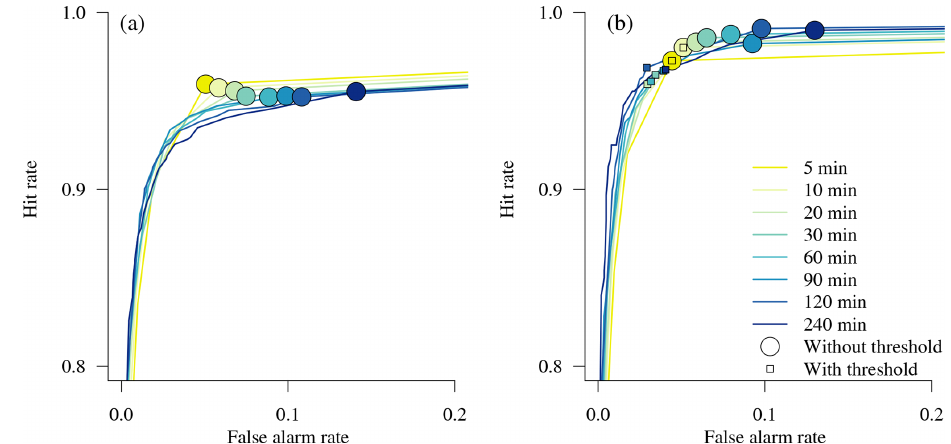
Figure 4. Receiver operating characteristic (ROC) curves showing hit and false alarm rates of the Thies disdrometer with respect to the detection of precipitation using the OTT pluviometer as a reference. (a) Exploration of hit and false alarm rates during the whole time series (2 years). (b) Effect of applying minimum precipitation thresholds on hit and false alarm rates during the second year of measurements. Note that the proposed thresholds are established during the first year of measurements in order to reduce false alarm rates, particularly for longer integration times.